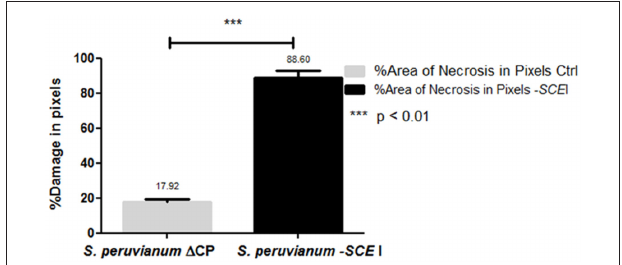
FIGURE 5 | Damaged leaf tissues in empty vector-treated or SCEI-silenced S. peruvianum plants at 20 dpi with Cmm .